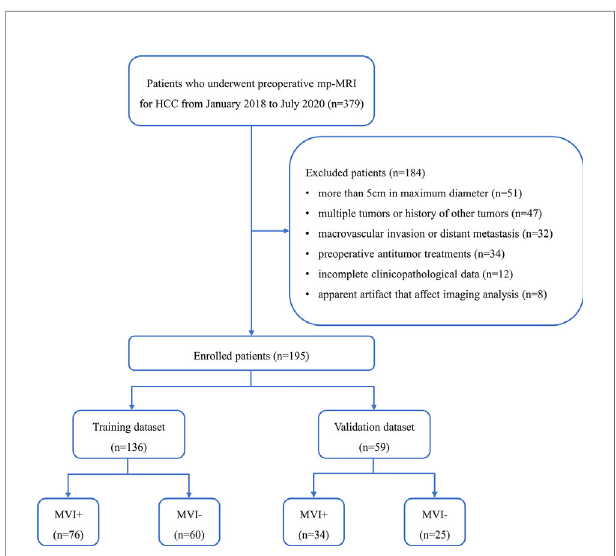
FIGURE 1 | Flowchart of the enrolled patients. (HCC, hepatocellular carcinoma; mp-MRI, multi-parametric MRI; MVI+, patients with microvascular invasion; MVI − , patients without microvascular